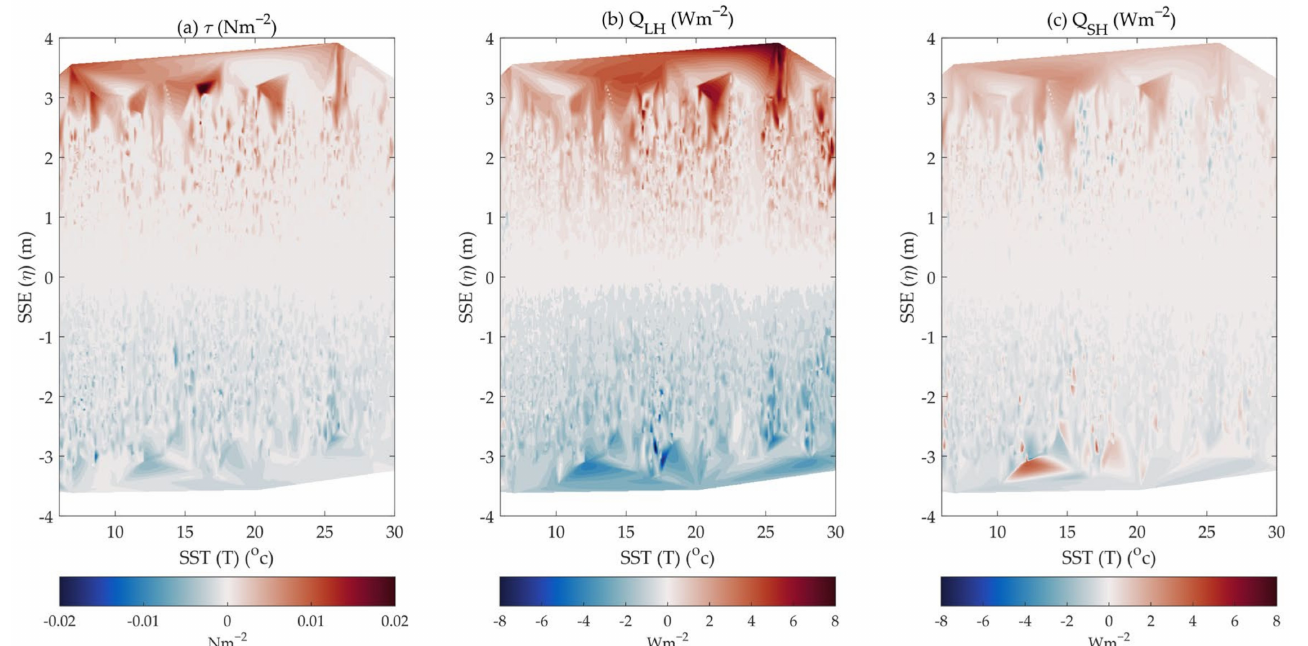
Figure 6. ( a ) Wind stress differences between magnitudes with and without the inclusion of SSE with variations in magnitudes of SSE (y-axis) and SST (x-axis). The colours represent the magnitudes of differences. ( b , c ) are the same as ( a ) but for latent heat flux (unit: Wm − 2 ) and sensible heat flux (unit: Wm − 2 ), respectively. Note that the results in ( a – c ) are interpolated based on the platform observations in the ECS with some missing